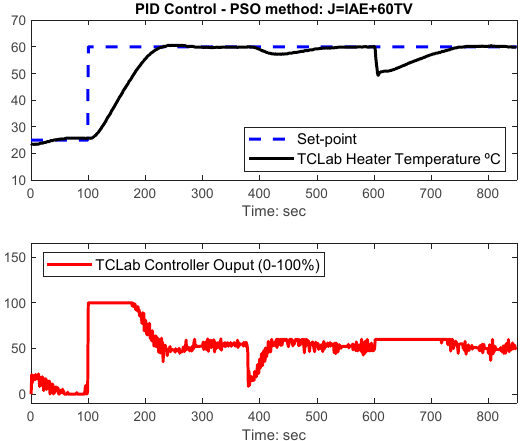
Figure 18. TCLab responses using PSO (J = IAE + 60 TV). Output disturbance considered at t (cid:27) 600